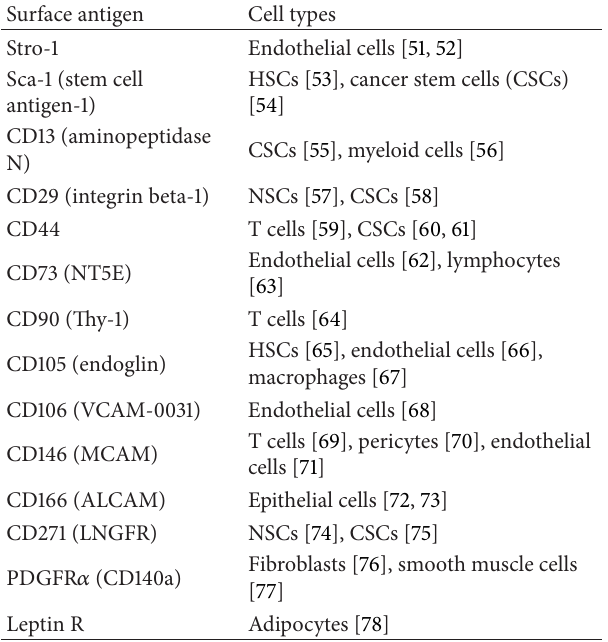
Table 1: Heterozygous cell population of MSC surface markers. Surface